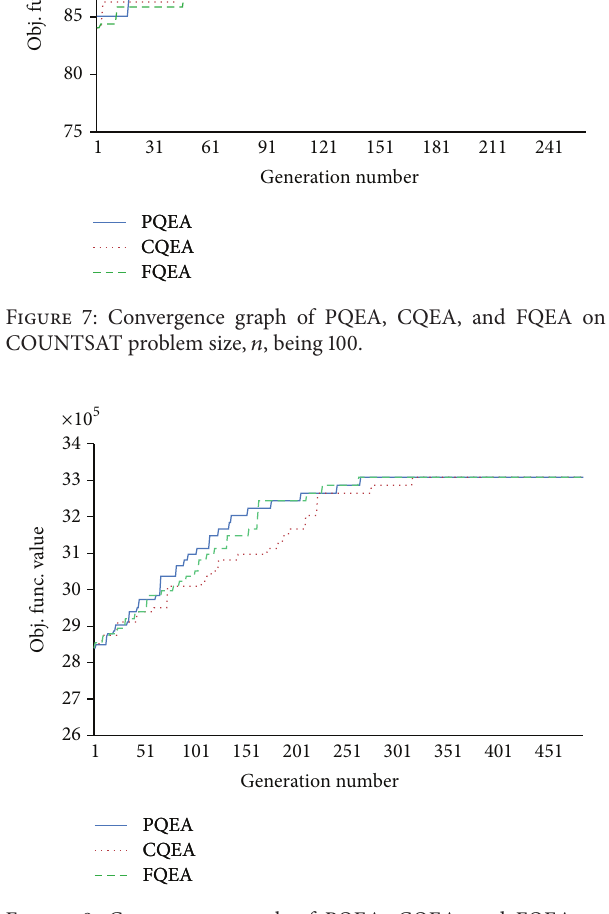
Figure 8: Convergence graph of PQEA, CQEA, and FQEA on COUNTSAT problem size, 𝑛 , being